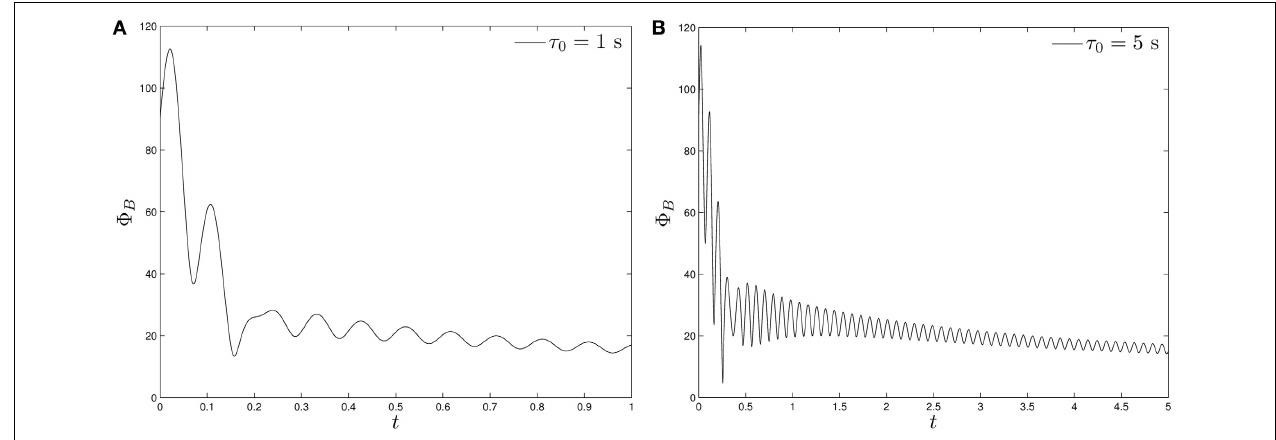
FIGURE 5 | The angle (cid:3) B of a swimming rod-shaped magnetotactic bacterium as a function of time starting from (cid:3) B = 90 ◦ under the influence of a rotating magnetic field (Equation 39) with B 0 = 14 . 00 × 10 − 4 T and (cid:2) 0 = 2 . 5133/s: (A) for τ 0 = 1 s and (B) for τ 0 = 5 s.